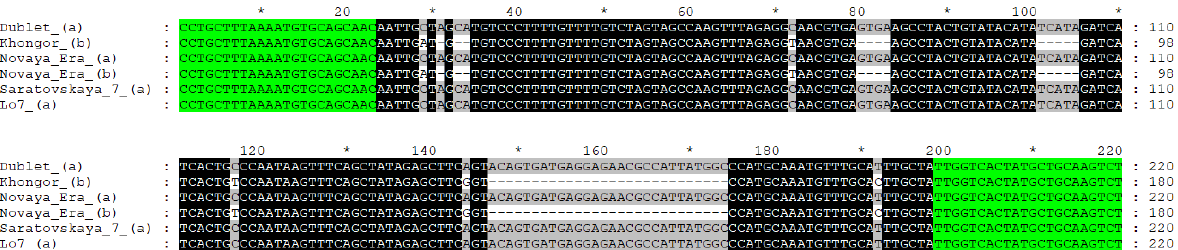
Figure 1. STS marker design based on polymorphisms in the 3rd intron of the ScGrf3-2R gene. The sequences of the flowing accessions are shown: triticale, Dublet ( ScGrf3-2Ra ), and Khongor ( ScGrf3- 2Rb ); rye, Novaya Era (both alleles), and Saratovskaya 7 ( ScGrf3-2Ra ); reference genome sequence of rye Lo7 ( ScGrf3-2Ra ). The sequences of the designed primers are highlighted in